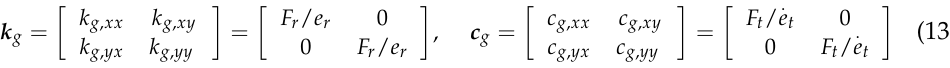
Finally, stiffness and damping matrices of a particular orbit radius and rotor speed result in: (cid:20) k g , xx k g = For this purpose, a circular journal movement must be specified using a journal bearing calculation program. Despite the circular journal orbit, the forces may differ from a circular shape. The coefficients are determined for each point on the orbit and averaged over one revolution. Figure 4 exemplarily shows the impact of rotor speed and orbit radii on bearing stiffness and damping